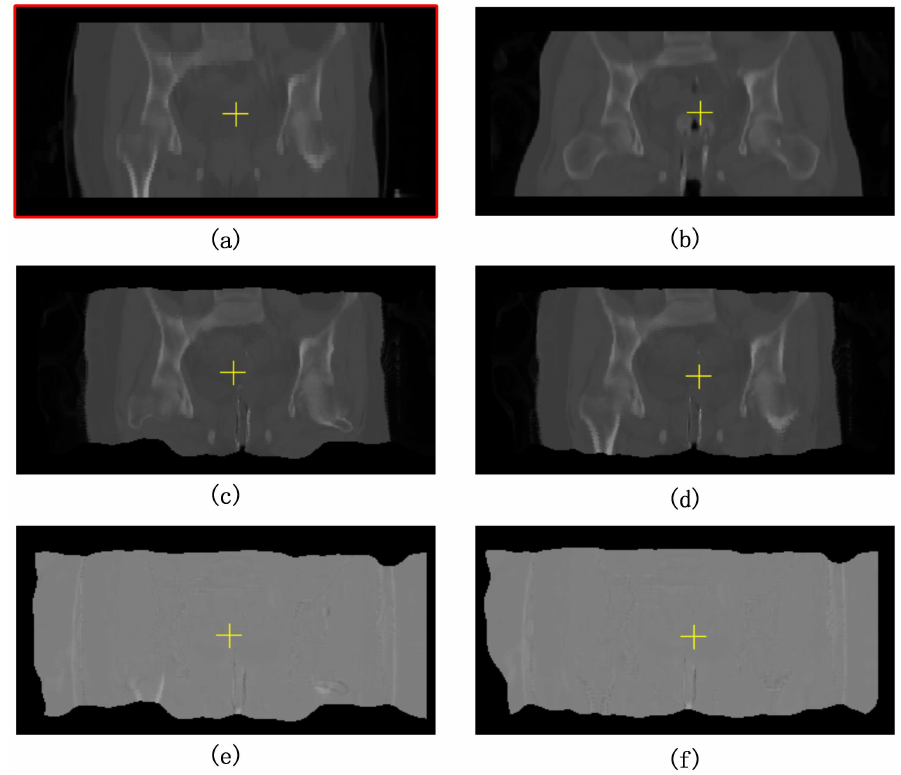
Fig 9. Comparison of registration results using FFD and LFFD+FFD non-rigid registration respectively. (a) EBRT image used as a reference. (b) Initialized HDR-BT image before non-rigid registration. (c) HDR-BT image after (FFD) non-rigidregistration. (d) HDR-BT image after (LFFD+FFD) non- rigid registration.The correspondingdifference images are shown in (e) and (f).